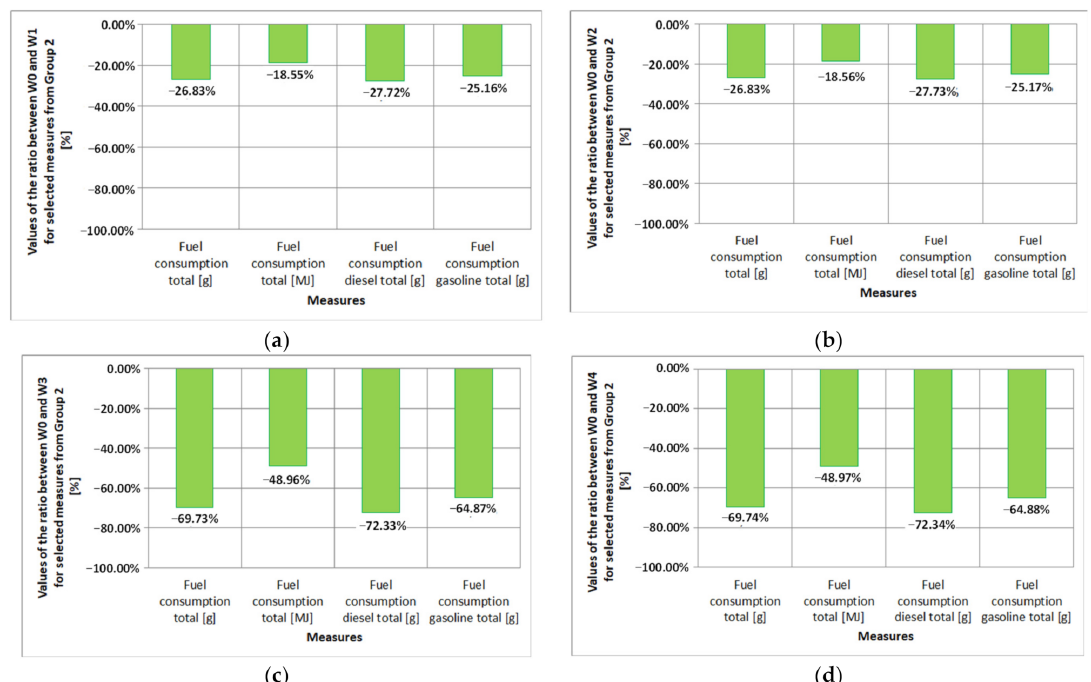
Figure 22. Values of the ratio between W0 and individual scenarios W1–W4 for selected measures from Group 2—analysis for the whole city: ( a ) the ratio between scenario W0 and W1; ( b ) the ratio between scenario W0 and W2; ( c ) the ratio between scenario W0 and W3; ( d ) the ratio between scenario W0 and